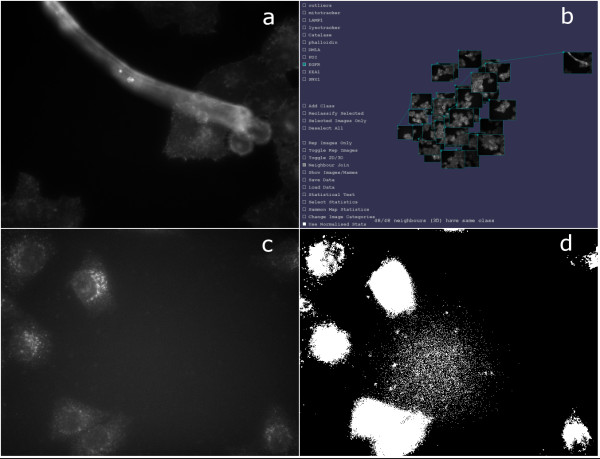
Outlier images. Images that are statistical outliers may be caused by a protein localisation that is distinct from the majority of cells imaged; artefacts in imaging; or an artefact in the generation of the statistics. (a) shows an imaging artefact, perhaps caused contamination of the slide. (b) shows the same image (upper right) in the context of the 3D placement by iCluster of other images of the same class. (c) shows another outlier image found using iCluster. In this case a non-uniform background has caused the automatically generated region of interest selection mask (d) to select non-cellular regions, thus skewing the statistics calculation.